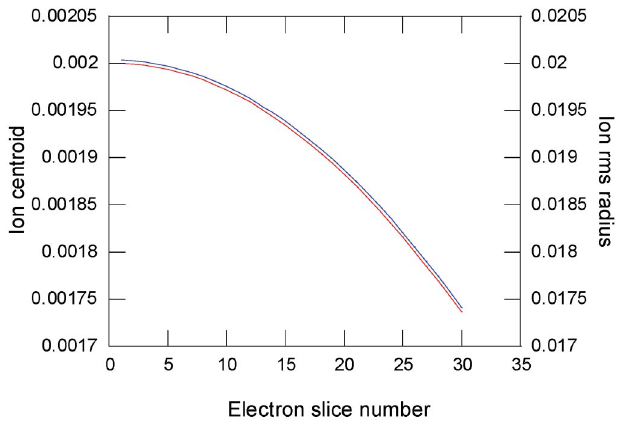
FIG. 8. (Color) Evolution of both the ion centroid and rms radius, for the test case using only the electrons’ space charge to check the ion distribution calculation. The red line is for the ion centroid and the blue line is for the ion rms